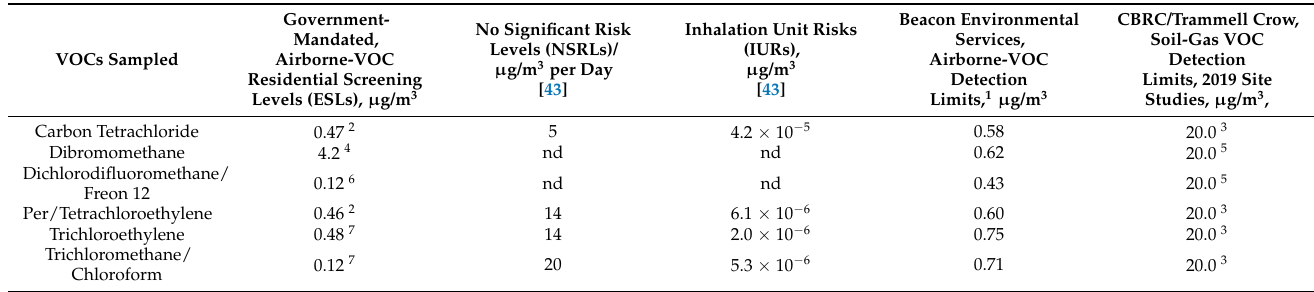
Table 3. Safety Benchmarks and Detection Limits, Former Naval Ordnance Testing Station, Pasadena (NOTSPA). Government- VOCs Sampled